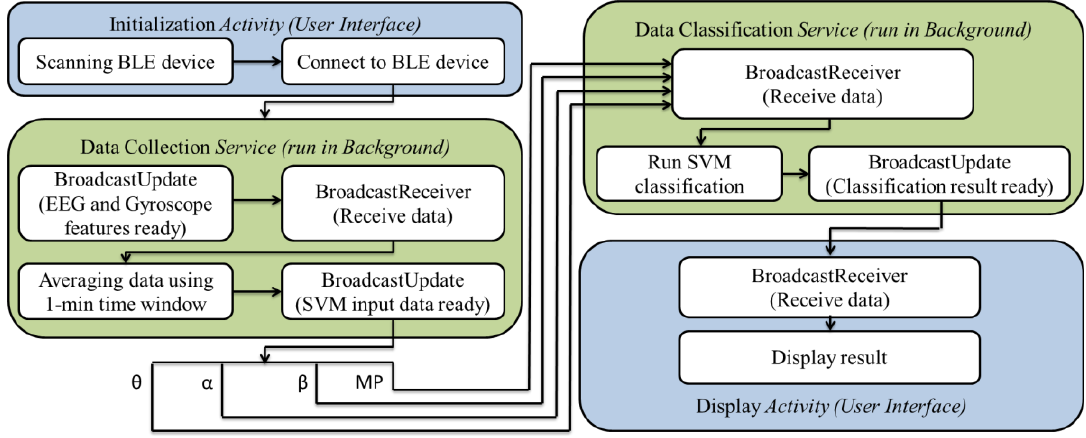
Figure 5. The working flowchart of smartphone which consists of two Activities (User interfaces) and Services (The functions running in